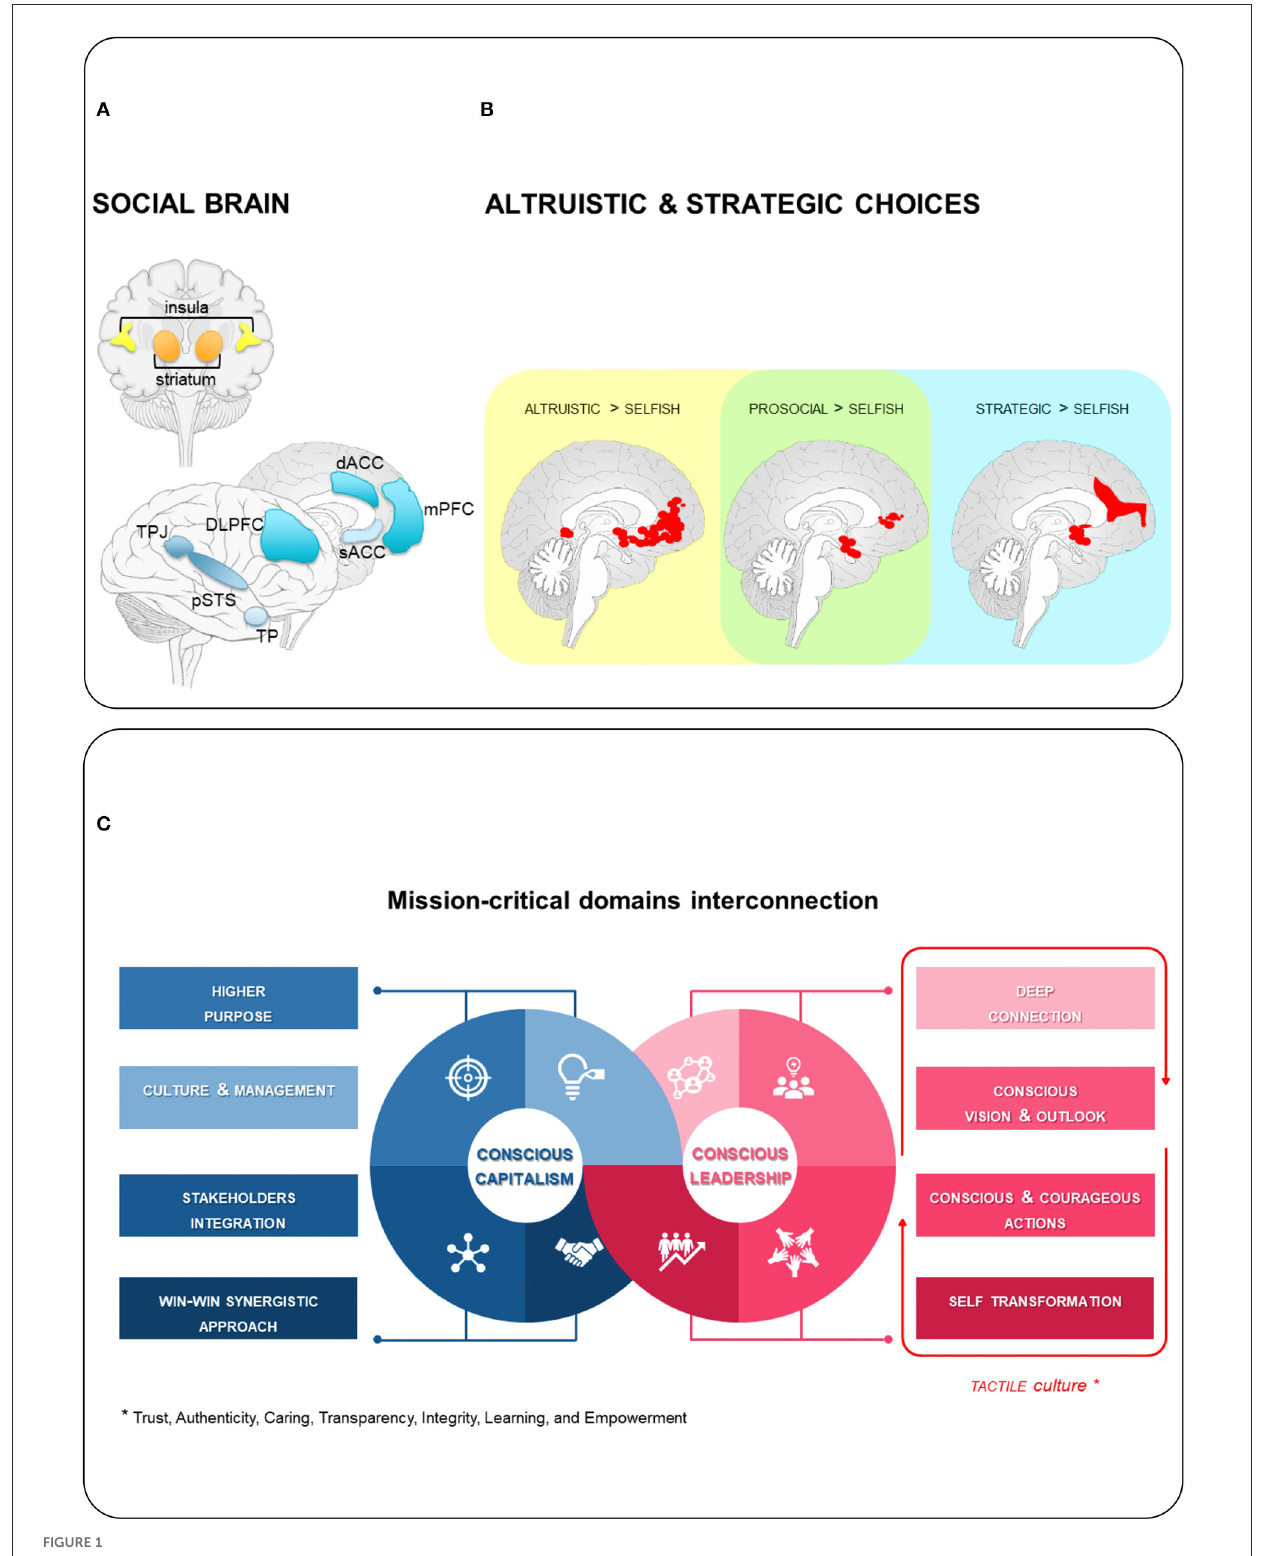
FIGURE1 (A) Social brain is primarily involved in social cognition (adapted from Windmann and Hein, 2018). Main core hubs shown. TPJ, temporal parietal junction; dACC, dorsal anterior cingulate cortex; MPFC, medial prefrontal cortex; sACC, sugbenual anterior cingulate cortex; DLPFC, dorsolateral prefrontal cortex; TP, temporal pole; pSTS, posterior part of the superior temporal sulcus. (B) Consistent neural underpinnings of altruistic and strategic choices concerning giving behavior (adapted from Cutler and Campbell-Meiklejohn, 2019). (C) Conscious capitalism and leaders interconnections become the foundation of a new organization’s operating philosophy. Philanthropy becomes a policy of donating part of the profit to non-profit organizations with emphasis on intrinsic motivation and contribution to social needs through the choice and the quality of goods and services. On the leadership side, there is a mutual reinforcement between vertical learning principles thanks to the TACTILE